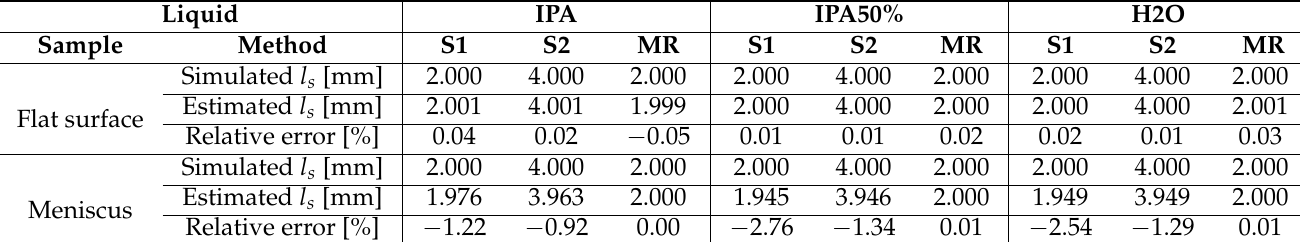
Figure 7. The relative error of sample height versus frequency determination for ( a ) IPA, ( b ) 50% aqueous solution of IPA and ( c ) distilled water. Line types: solid—the ideal sample with the flat surface, dashed-dotted—the sample with the meniscus (denoted by ~). Line colors: red—the outcome of the meniscus removal (MR) method, blue and yellow—Somlo’s method [15] for the initial (S1) and the final (S2) volumes of liquid, respectively. Table 2. Juxtaposition of the simulated and estimated column heights of samples l s with their relative errors determined for different liquids, sample surface types (the flat and with the meniscus) and the methods used: S1, S2—Somlo’s method for the initial and final volumes of liquid, respectively, MR—the meniscus removal method for the incremental column